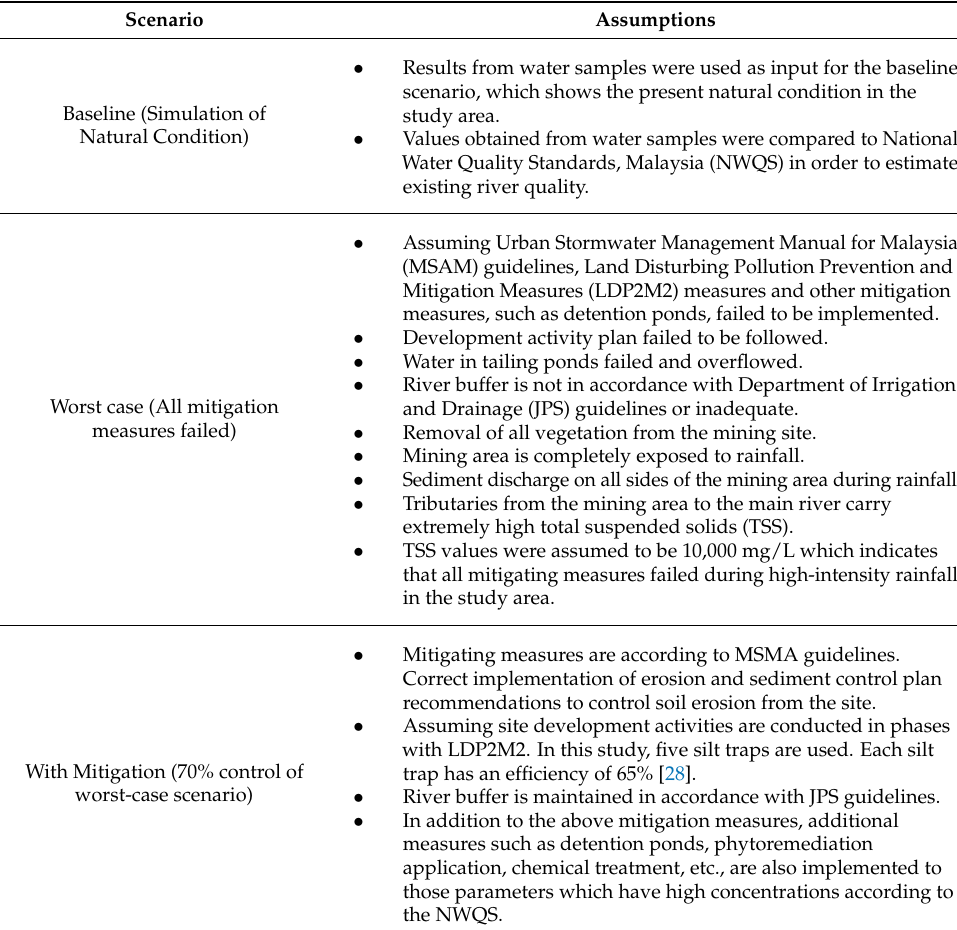
Table 2. A brief introduction of three scenarios used in the water quality